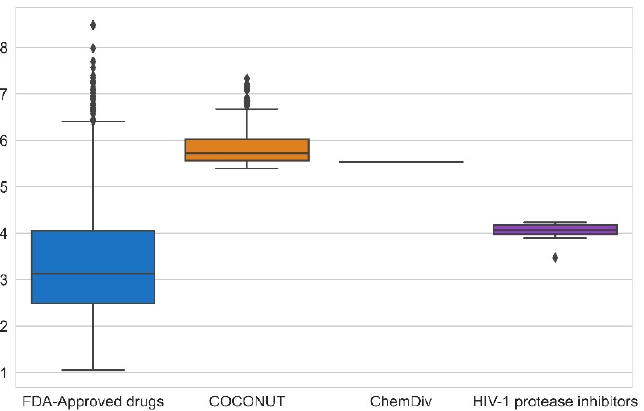
Figure 9. Box-whisker plot of synthetic feasibility calculated for FDA-approved drugs (blue), FDA- approved HIV-1 protease inhibitors (purple), and new chemical compounds generated from CO- CONUT fragments (orange) and ChemDiv (red) fragments with physicochemical properties like FDA-approved HIV-1 protease inhibitors. Black diamonds represent outliers.